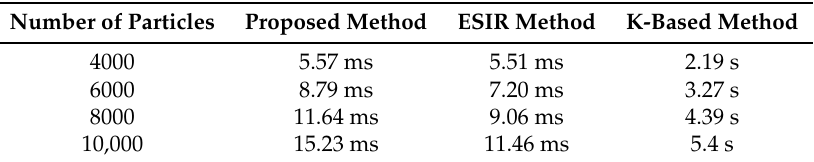
Table 1. Computational